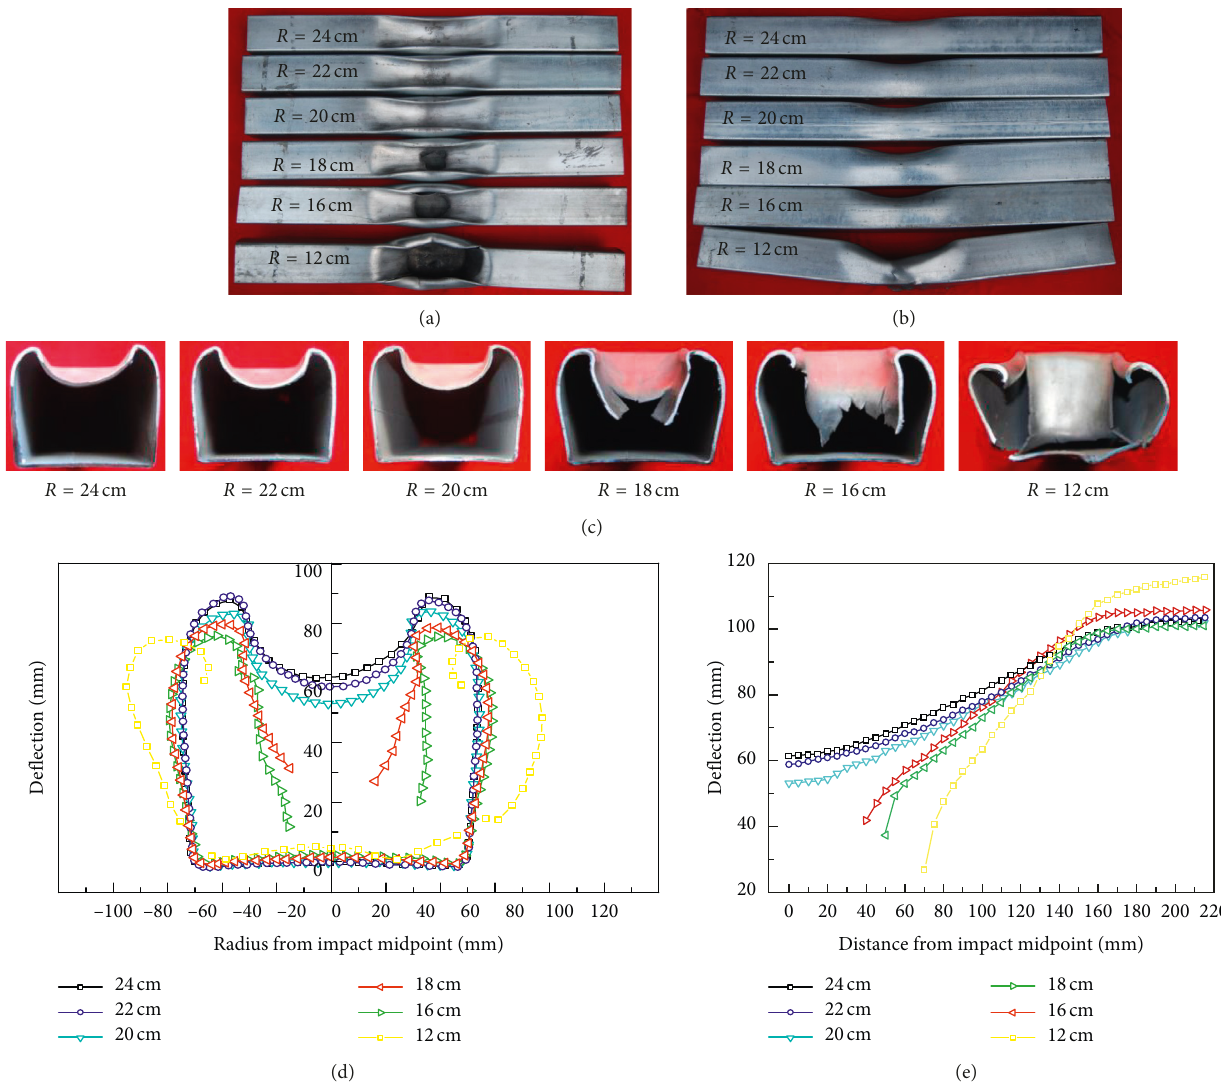
Figure 12: Damage of square tubes with a thickness of 3.0mm at different stand-off distances. (a) Planform view. (b) Side view. (c) Cross section. (d) Deformation curve on cross section. (e) Deflection in axial